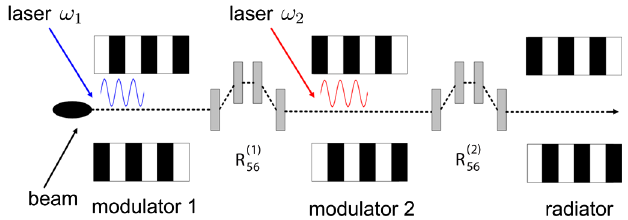
FIG. 1. (Color) Schematic of the EEHG FEL. The beam energy is modulated in the first undulator (modulator 1) tuned at frequency ! 1 due to the interaction with the first laser beam. After passing through the first dispersion section with R ð 1 Þ 56 , the beam energy is then modulated in the second undulator (modu- lator 2) tuned at frequency ! 2 due to the interaction with the second laser beam. The beam passes through the second disper- sion section R ð 2 Þ 56 and emits radiation in the last undulator